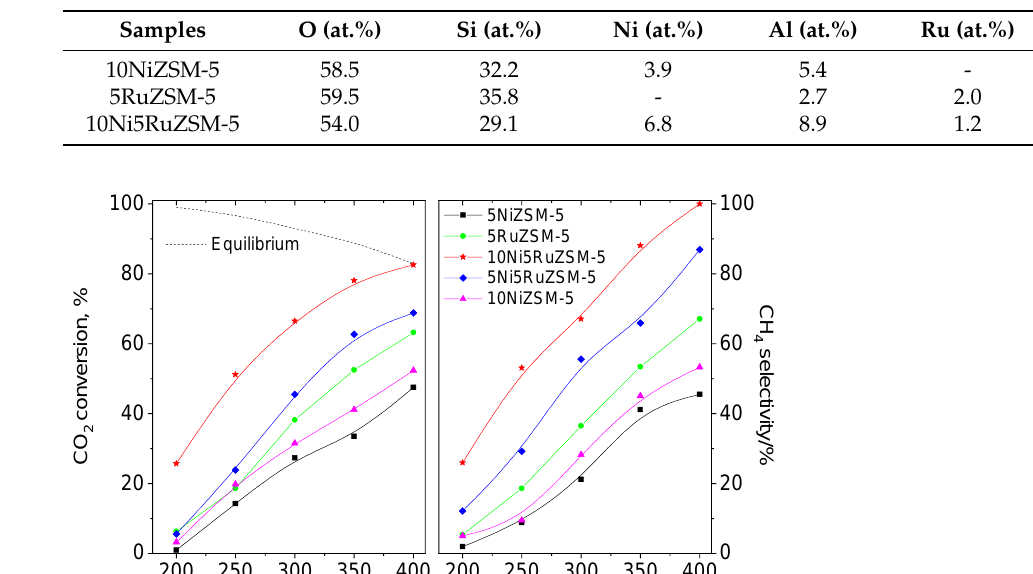
Figure 5. Ru3d and Ni2p 3/2 XPS spectra of the reduced 10NiZSM-5, 5RuZSM-5 and 10Ni5RuZSM-5 zeolites. Table 3. Surface chemical composition of the parent catalysts.